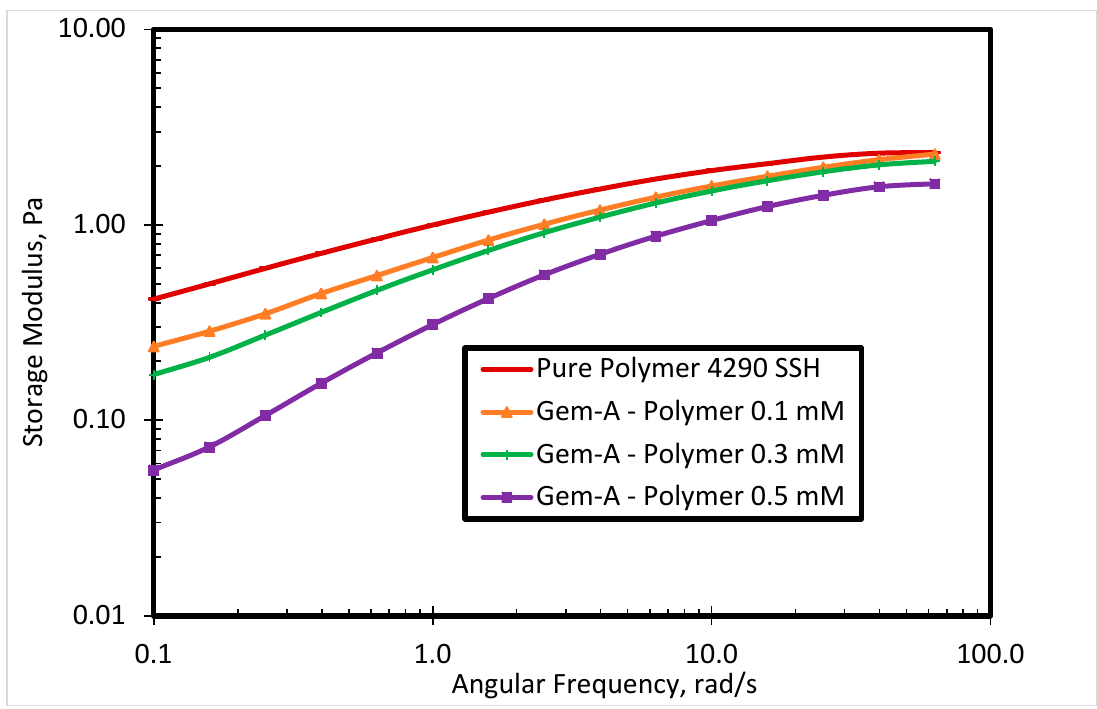
Figure 9. The storage modulus of 4290 SSH polymer with Gem-A surfactant at di ff erent concentrations.